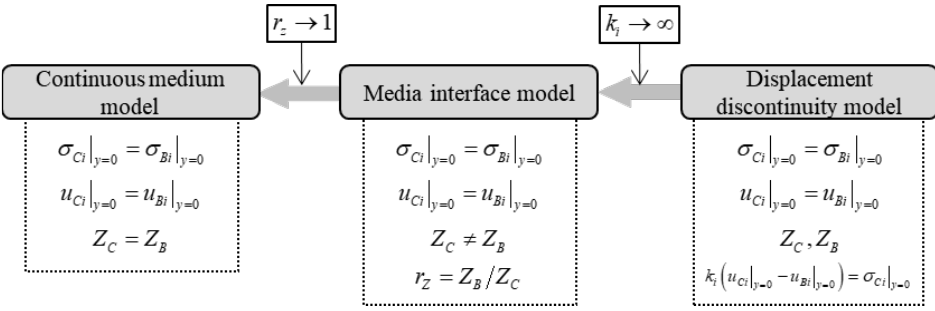
Figure 10. Continuity changes of models I, II and III ( i = x , y ).